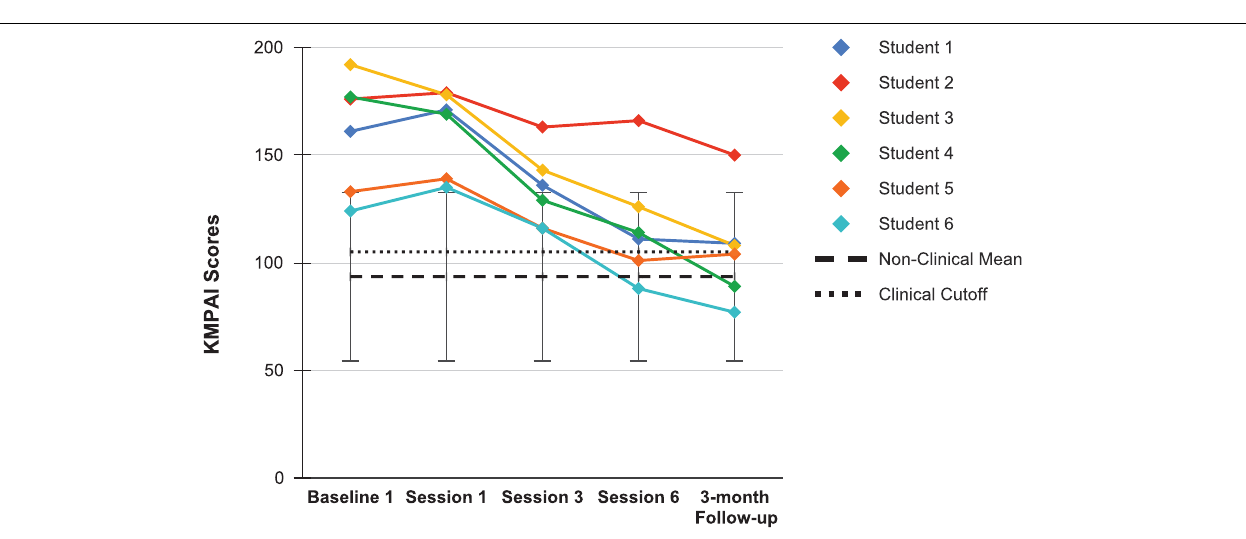
FIGURE 8 | Kenny Music Performance Anxiety Inventory scores for the current students, from the screening assessment (Baseline 1) pre-coaching (Session 1), midway (Session 3), post-coaching (Session 6), and the 3-month follow-up, with the mean for musicians under age 30 (93.5), standard deviation bars ( SD = 39.1; Kenny et al., 2012), and the recommended clinical cutoff score (105; Ackermann et al.,